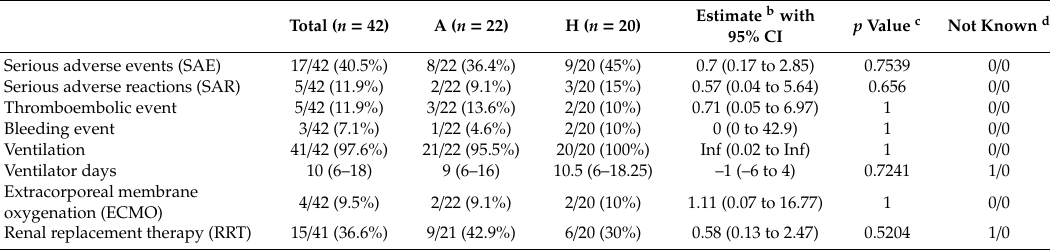
Figure 5. Median aPTT (95% CIs) during the study treatment from Baseline to Visit 6 (day 5) Depicted is the aPTT during treatment with heparin (orange) and argatroban (blue) after switch for only the patients who had to be switched. The upper dotted line at aPTT of 45 s represents the targeted aPTT. The black line indicates the di ff erence between the aPTT during administration of heparin or argatroban in the patients that had to switch. Values below the visit labels indicate the estimated di ff erences with 95% CIs between the aPTTs. V indicates the study visits at pre-defined time points. Table 3. Outcome a of